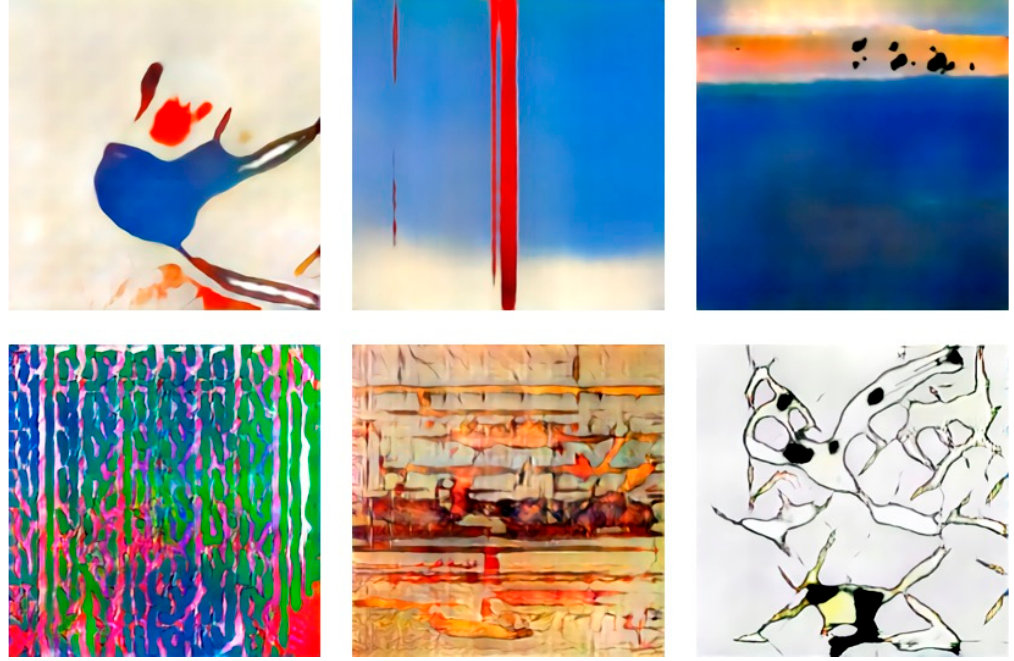
Figure 4. Examples of images generated by AICAN after training with images from all styles and genres from the past 500 years of Western art. Images courtesy of the Art & Artificial Intelligence Laboratory, Rutgers.